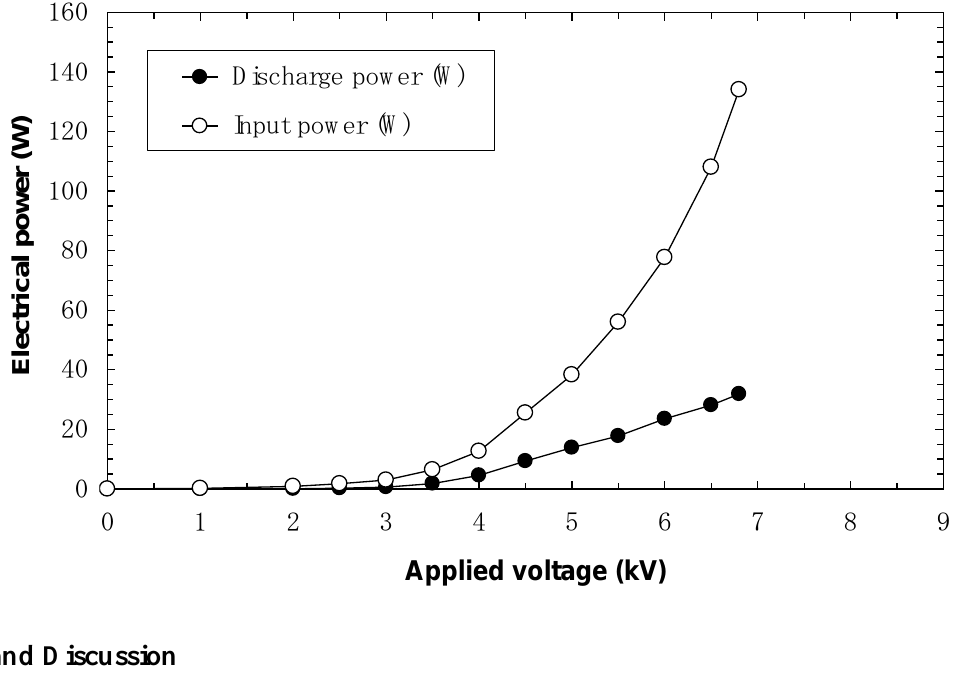
Figure 6. Electrical power vs. applied voltage for laminated film-electrode packed-bed plasma